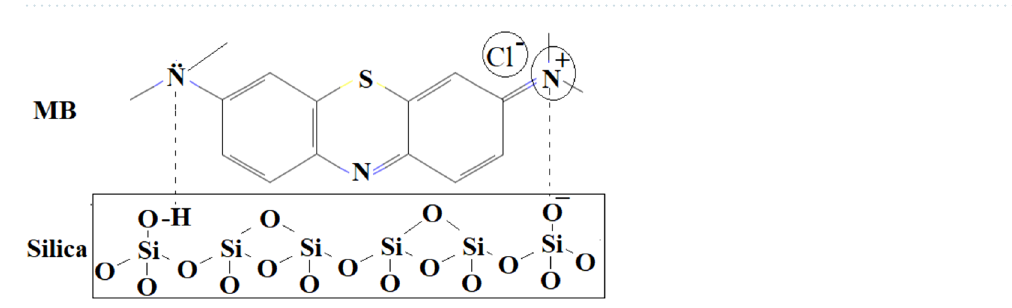
Figure 8. Scheme of interaction between MB and samples during